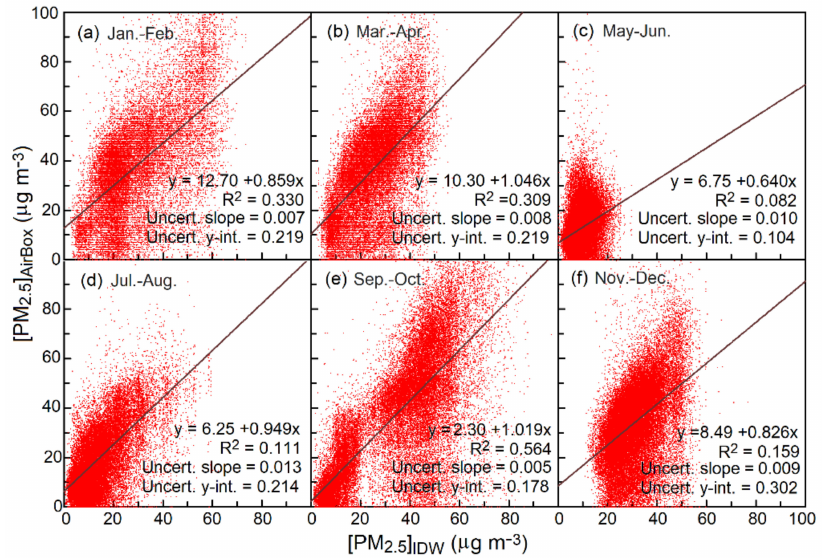
Figure 4. Observed PM 2.5 concentrations from the AirBox sensors ([PM 2.5 ] AirBox ) versus the spatial